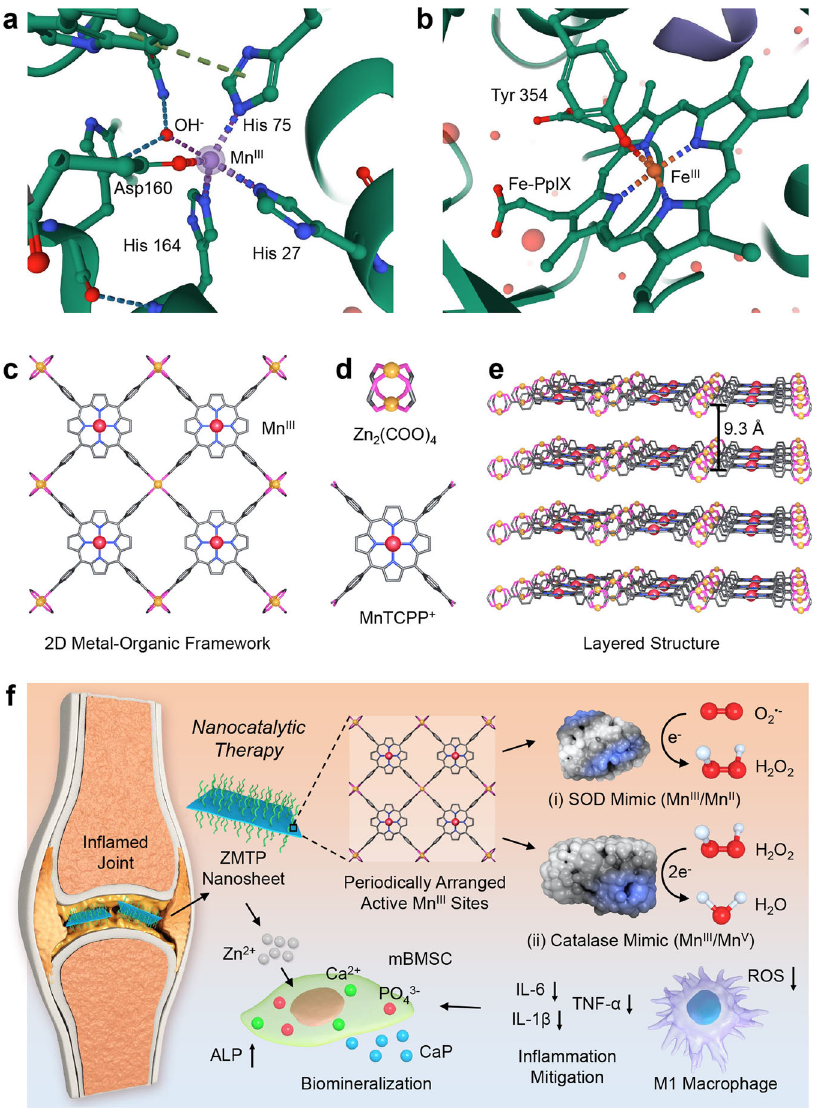
Fig. 1 Design concept of ZMTP nanosheets for catalytic rheumatoid arthritis treatment. a Coordination geometry around the Mn III center of human mitochondrial Mn-SOD (PDB: 1N0J). For better clari fi cation the H atoms are omitted. b Coordination geometry around the Fe III center in the heme group of human erythrocyte catalase (PDB: 1DGF). H atoms are also omitted. c Chemical structure of the 2D MOF ZMTP nanosheet, which fi xes and periodically assembles a metalloporphyrin MnTCPP + in a regular, ordered, and symmetric pattern. d Building units of ZMTP nanosheets, Zn(COO) 4 paddlewheel